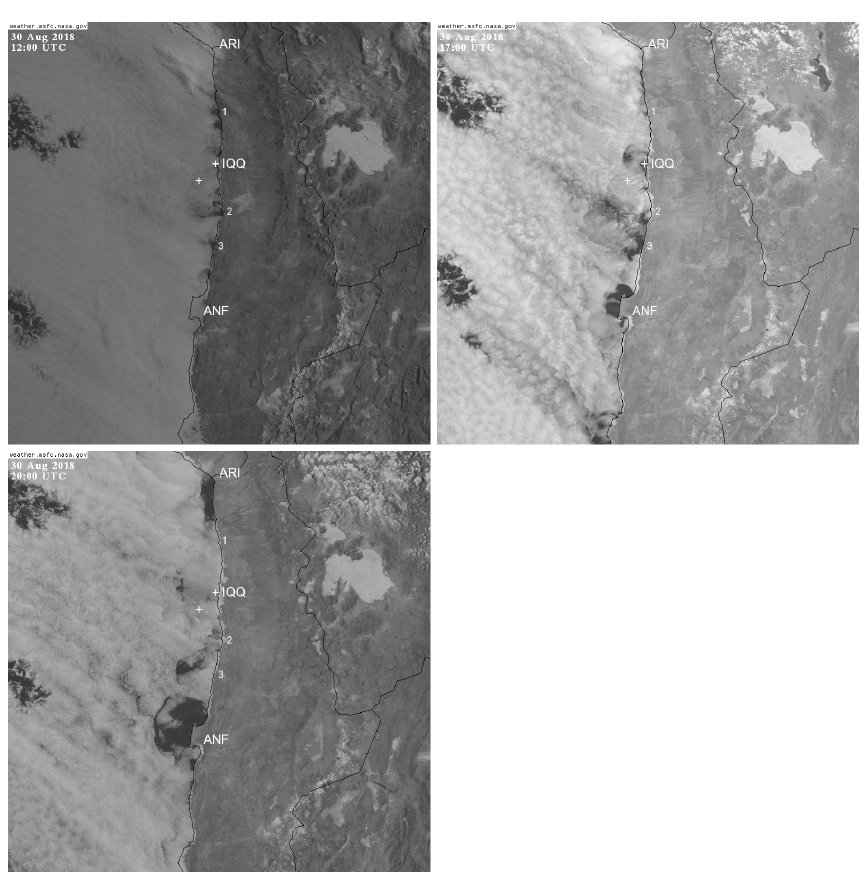
Figure 2. Scenes of the visible GOES16 channel of the 30 August 2018 morning (12:00UTC, top left), noon (17:00UTC, top right) and afternoon (20:00UTC, bottom left). The scenes are centered at 70 ◦ W and 21.9 ◦ S and cover about 800km × 800km. Three-letter codes indicate the locations of the airports of Arica (ARI), IQQ and Antofagasta (ANF). Plus signs indicate positions for which SST was extracted from GHRSST data (Naval Oceanographic Office, 2008). Digits 1–3 indicate locations of valleys cutting through the coastal mountain range. Thin black lines identify the coast or state boundaries, respectively. The large white area in the upper right corner of the satellite scenes is the salt pan Salar de Uyuni. The satellite scenes are courtesy of NASA Marshall Space Flight Center (https://weather.msfc.nasa.gov/goes/, last access: 6 September